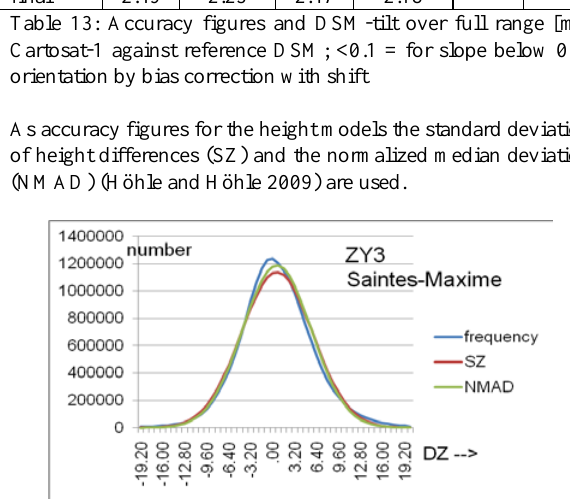
Figure 5. Frequency distribution of height differences ZY3 against reference with overlaid normal distribution for standard deviation and NMAD